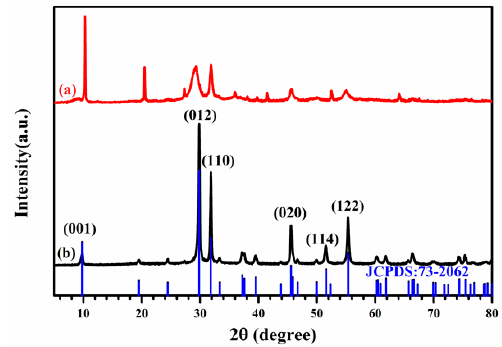
Figure 3. The XRD patterns of: ( a ) Bi 3 O 5 I 2 ; ( b ) BiOI.